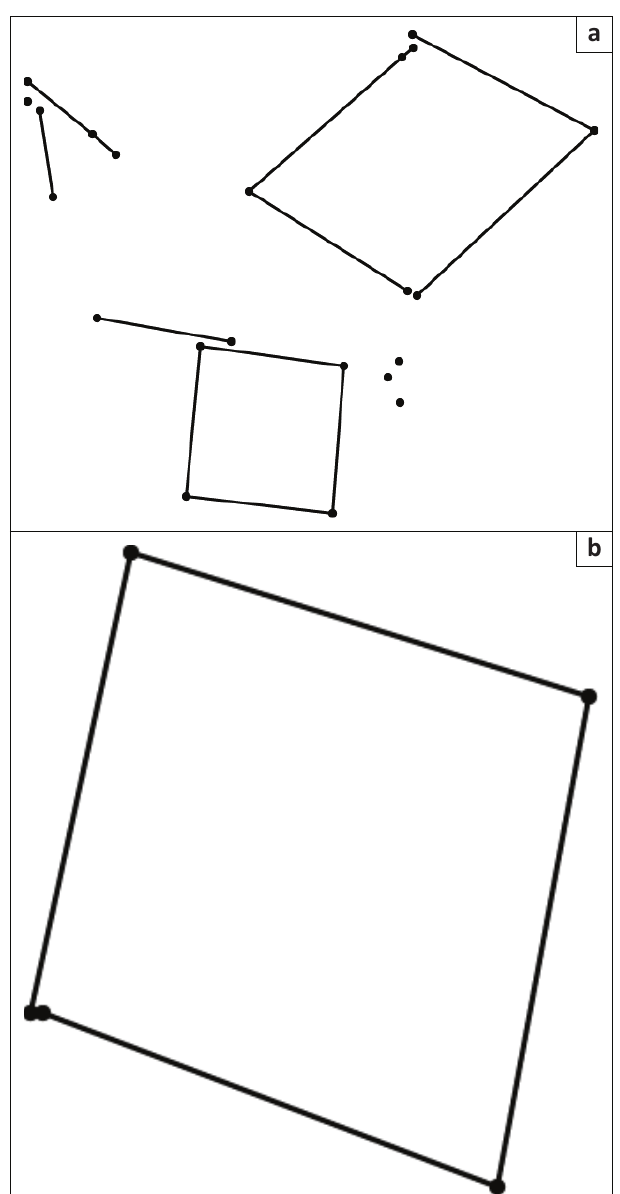
FIGURE 2: Attempted imagistic approximations to a